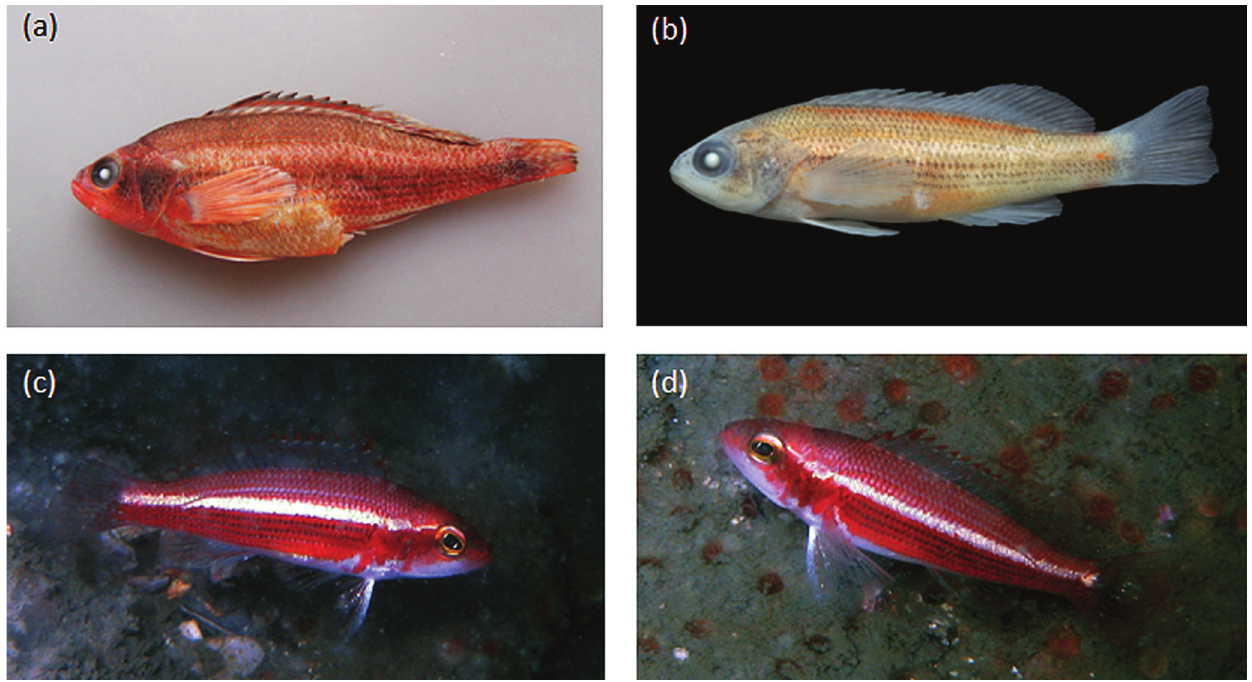
Fig. 2 . Serranus aliceae : a ) paratype, ZUEC 6354, 53.5 mm SL, recently fixed (photo by A. Carvalho-Filho); b ) paratype, CI- UFES 2368, 40.3 mm SL, after five days in ethanol (photo by R. M. Macieira); (c) and (d), underwater images at 35 (O. J. Luiz) and 40 m deep (C. E. L. Ferreira) on rocky reefs at Arraial do Cabo, Rio de Janeiro State, showing details of its live